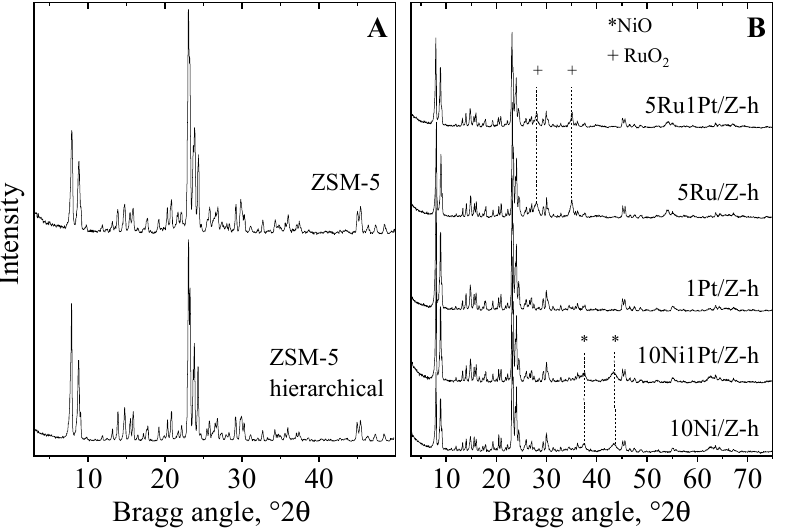
Figure 1. X-ray powder diffraction patterns of ( A ) initial and hierarchical ZSM-5 catalysts, and ( B ) the Ni-, Pt- and Ru-modified varieties.